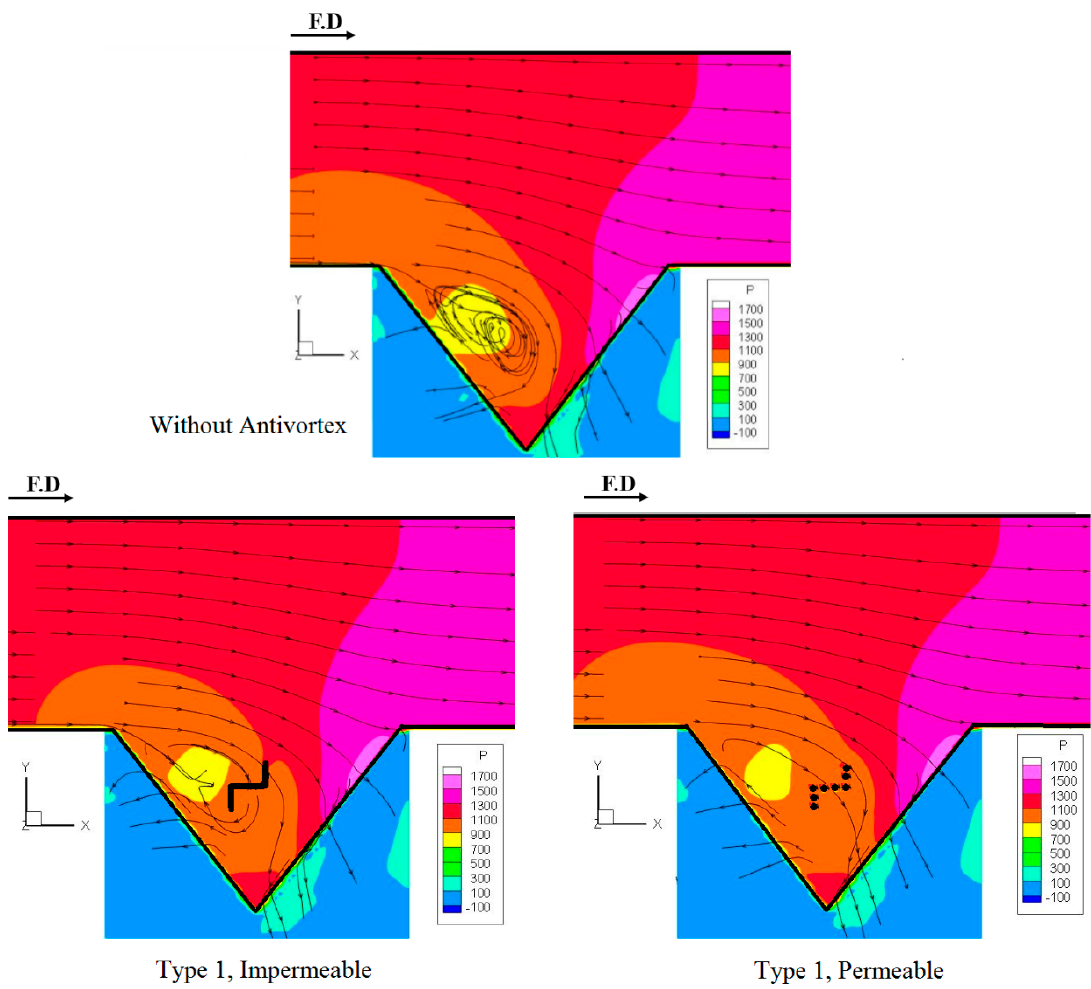
Figure 14. Longitudinal velocity contours near the surface and around the different antivortex structures.